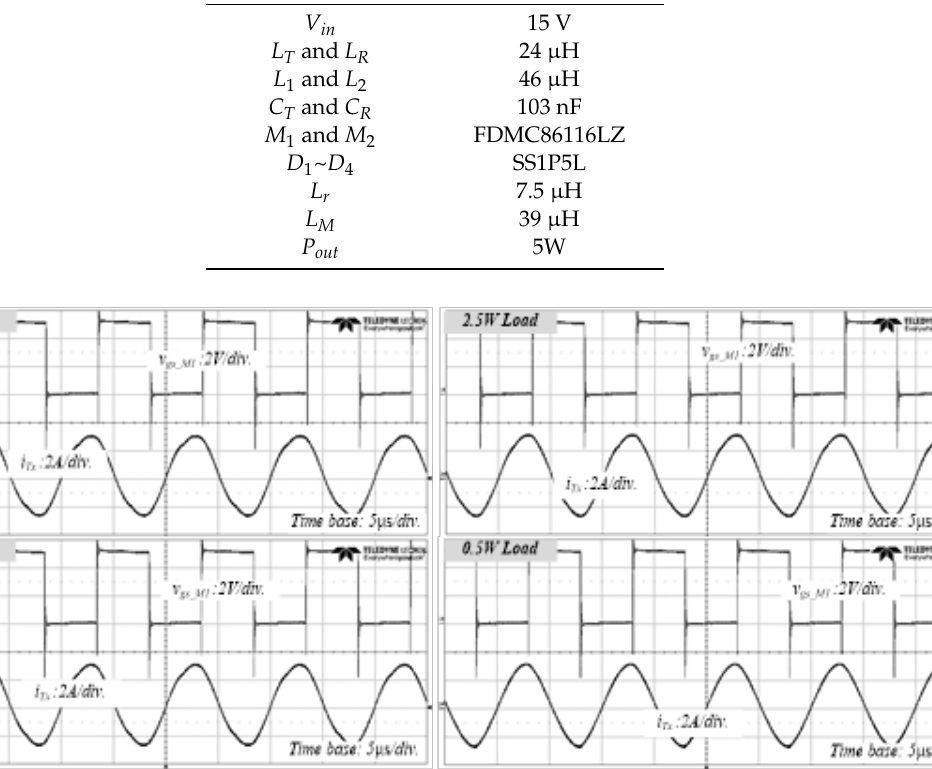
Table 1. Specific Components of the prototype.